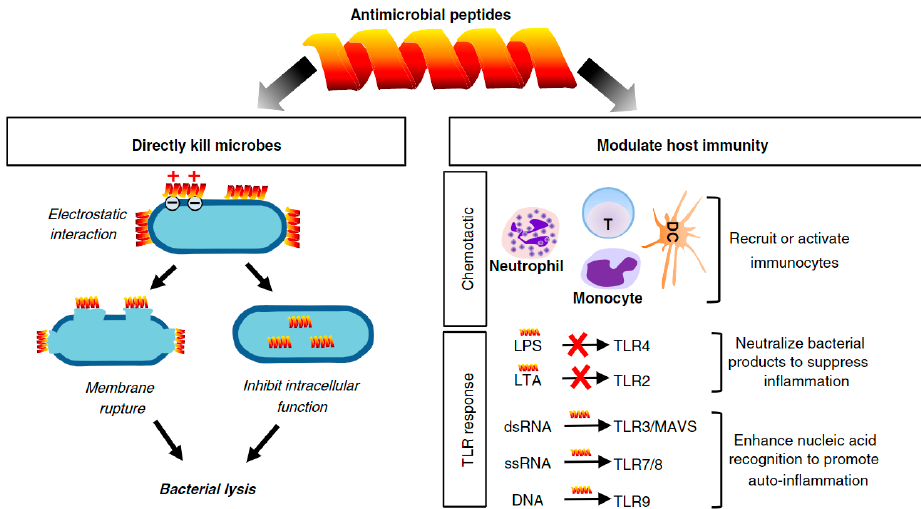
Figure 3. Biological functions of AMPs. AMPs bind to bacterial membranes through electrostatic interactions either to disrupt the membrane or to inhibit intracellular functions. Some AMPs also modulate host immunity by recruiting / activating immunocytes or by controlling the inflammatory response (used with permission from [157]).